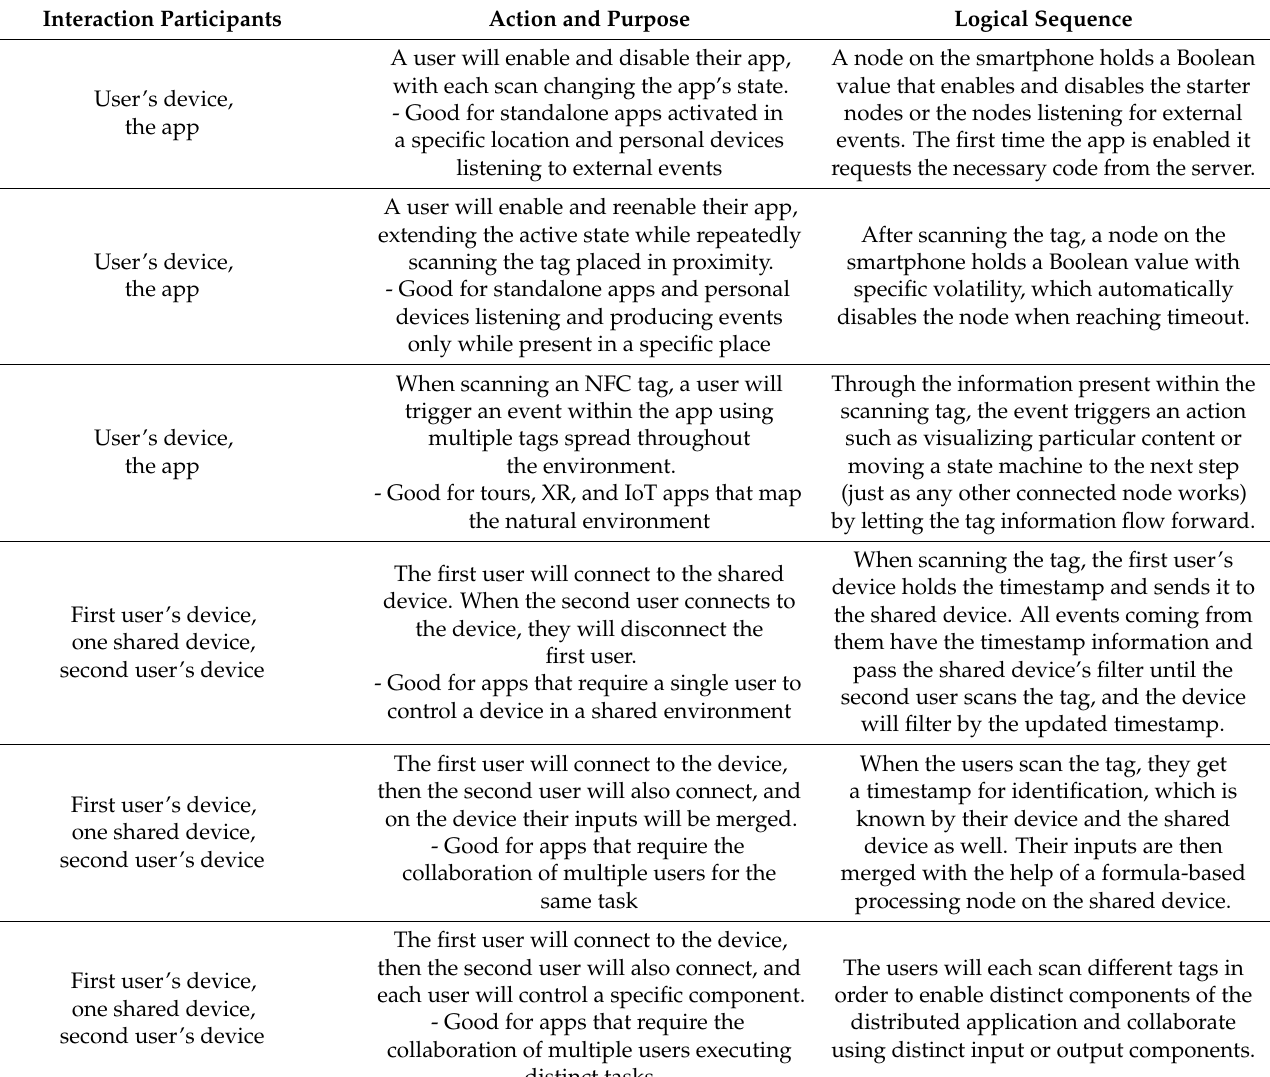
Table 1. The interactions a user may perform while exploring the smart environment by scanning NFC tags, detailed by interaction participants, sequence of action together with purpose, and the working-logic